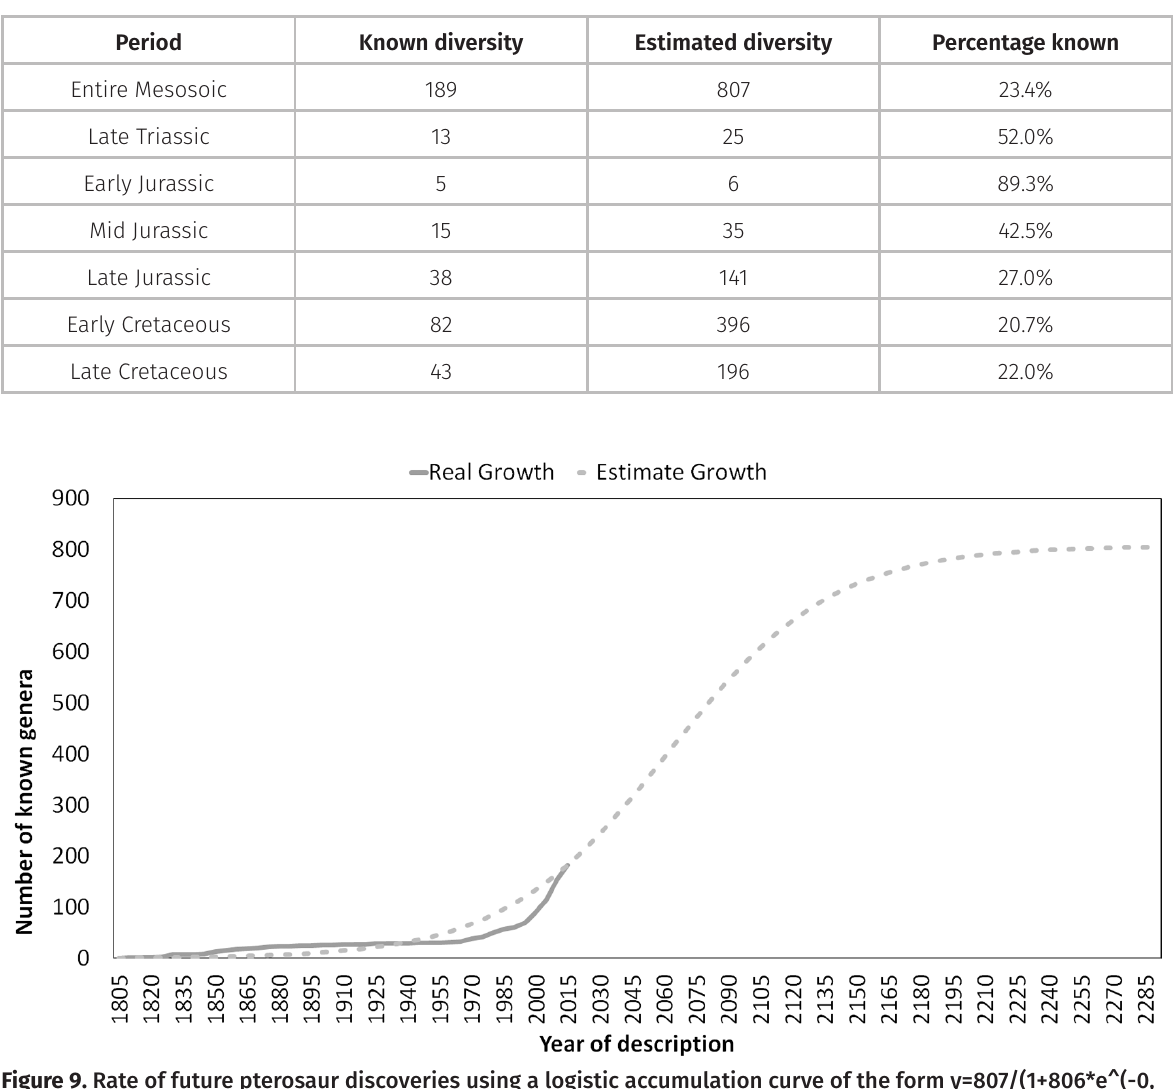
Table I. Generic diversity (richness) estimated for each Mesozoic periods and the entire Mesozoic. Since some genera are found in the interface of two epochs, the sum of the richness of these subperiods do not add up to the richness of the entire